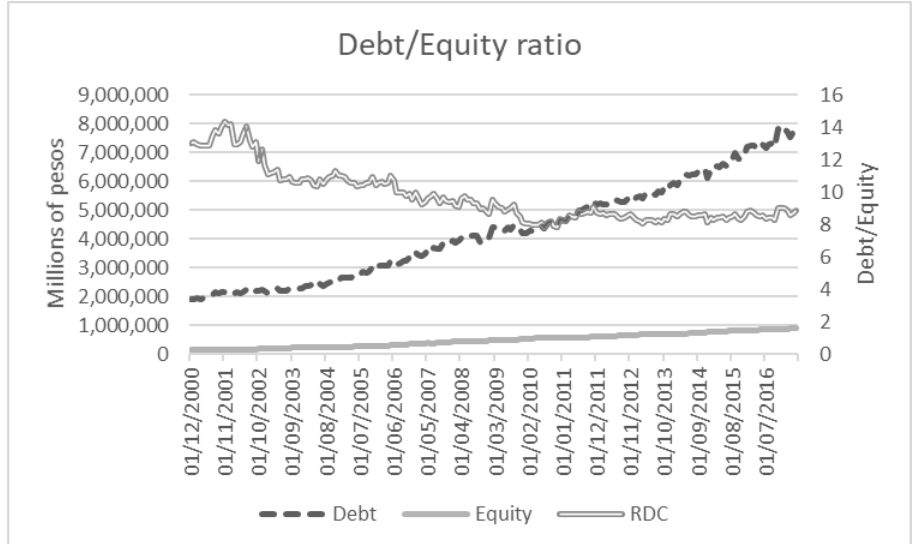
Figure 1. Total annual indebtedness of the Multiple Banking in Mexico. Source: Own elaboration l, with data obtained from the CNBV page (Comisión Nacional Bancaria y de Valores).